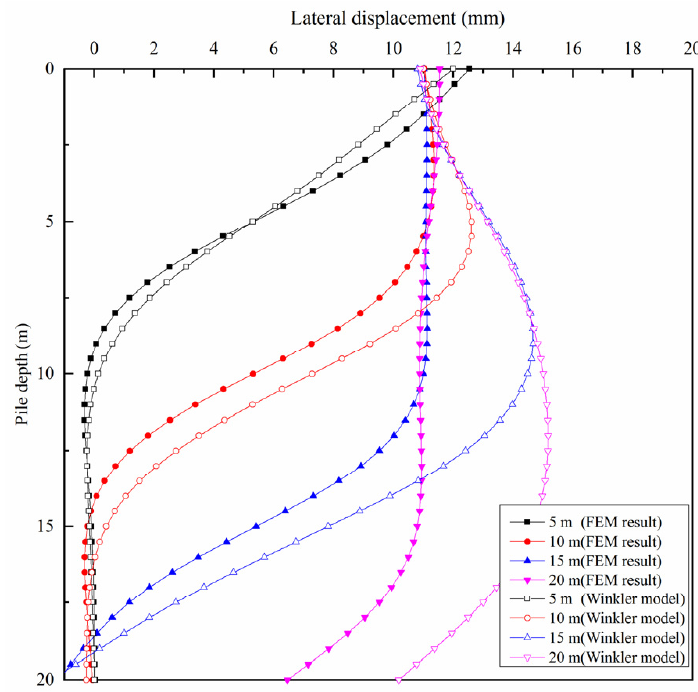
Figure 9. Comparison of calculation results between numerical simulation and Winkler foundation model with pile tip free.